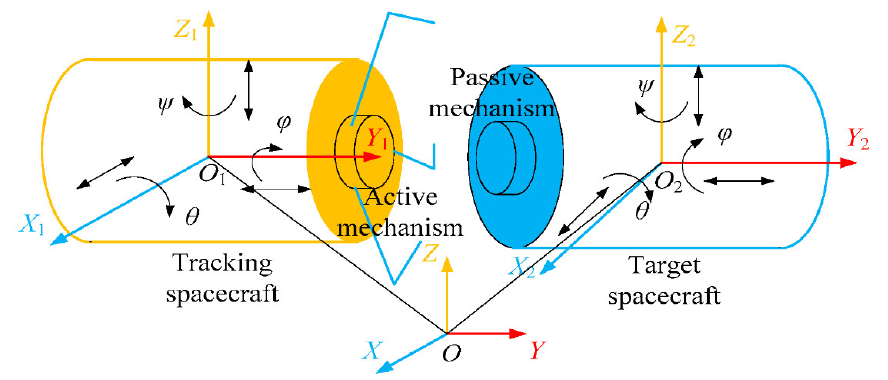
Figure 2. The space docking coordinate system.